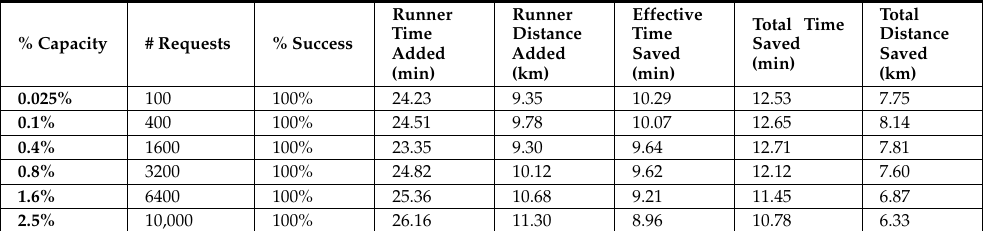
Figure 2. ( a ) presents the loss of as number of requests increase in Manhattan, New York. ( b , c ) high- light impact users and drivers willingness to wait drivers willingness to divert [21] ©2020 IEEE. Table 2. Results from New York taxi feasibility